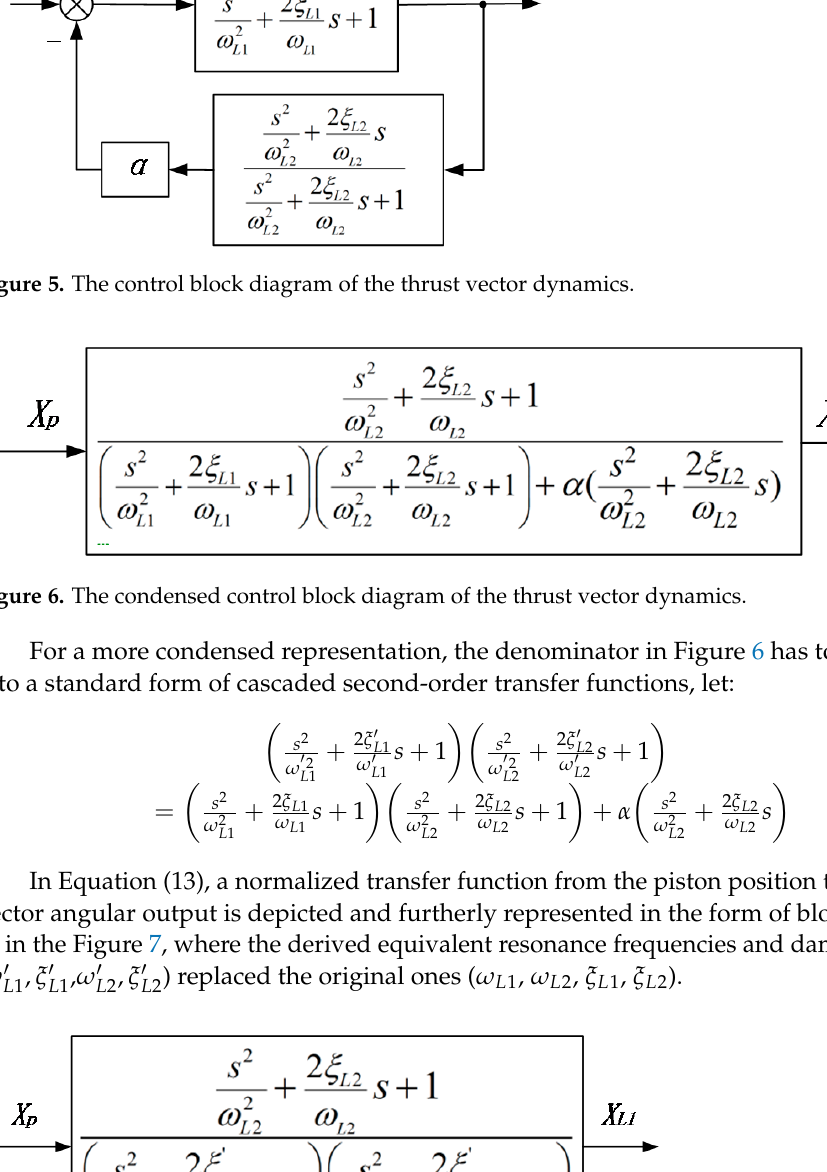
Figure 7. The normalized control block diagram of the thrust vector dynamics.